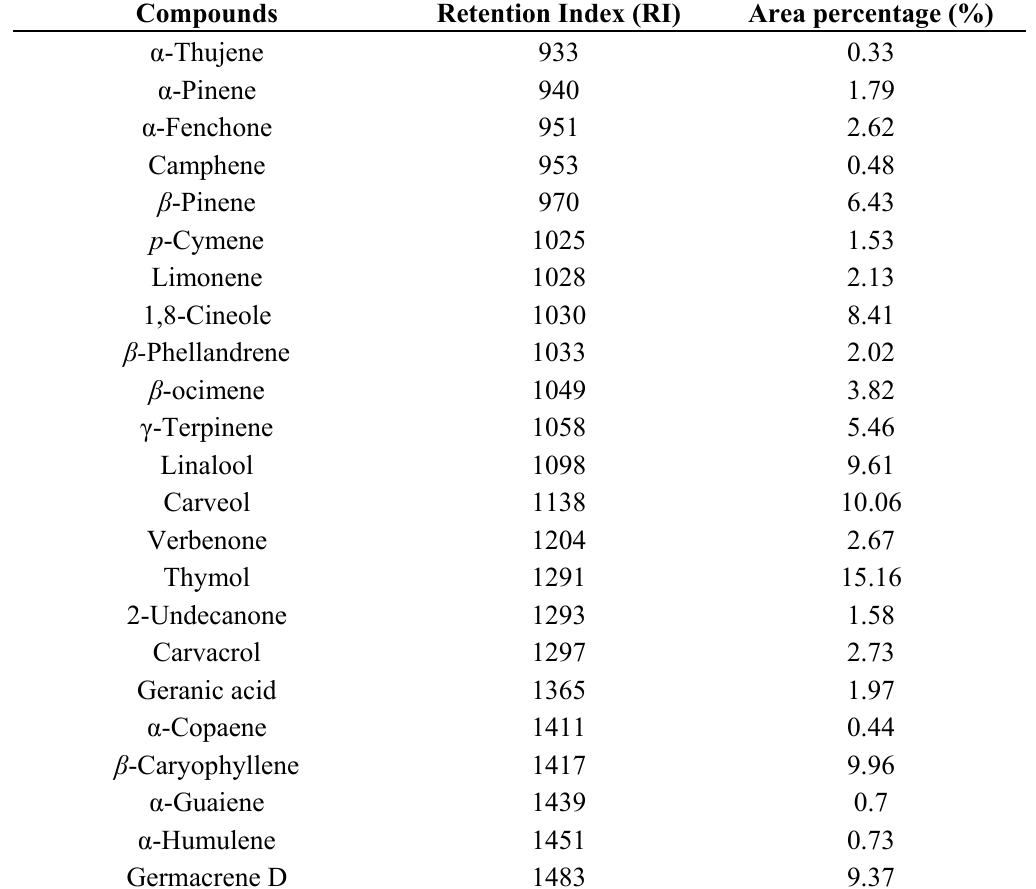
Table 1. Compounds identified in the essential oil of M. goodenifolius and their percentage